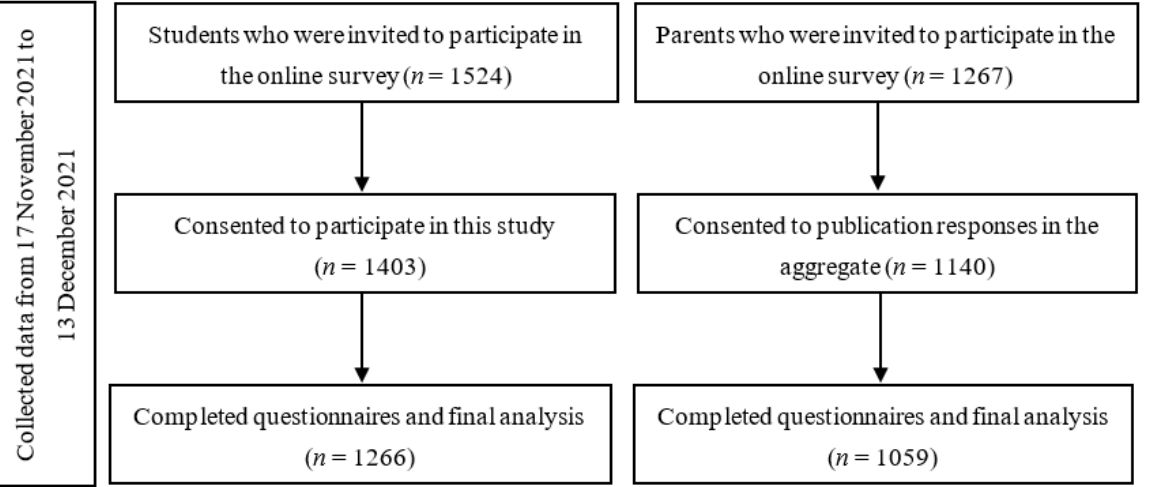
Figure 2. The study-flow diagram and pandemic period.